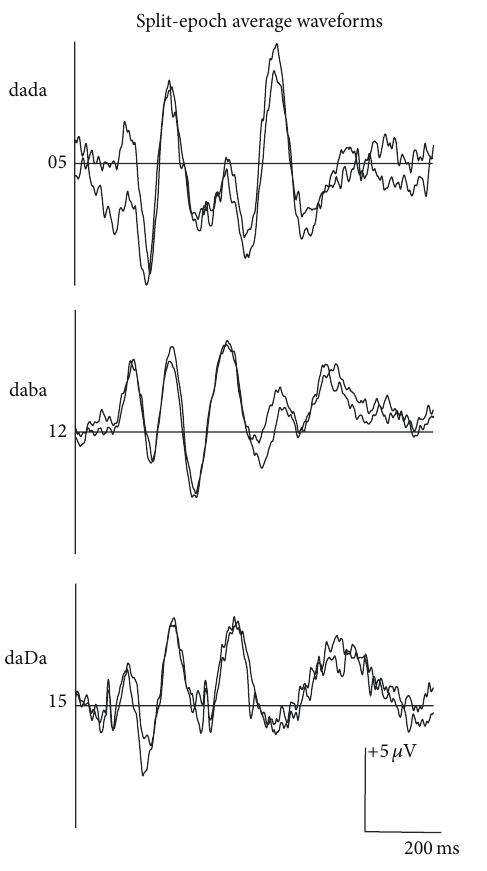
Figure 2: Split-epoch waveforms elicited to /dada/, /daba/, or /daDa/ for an individual infant participant for each stimulus con- dition.